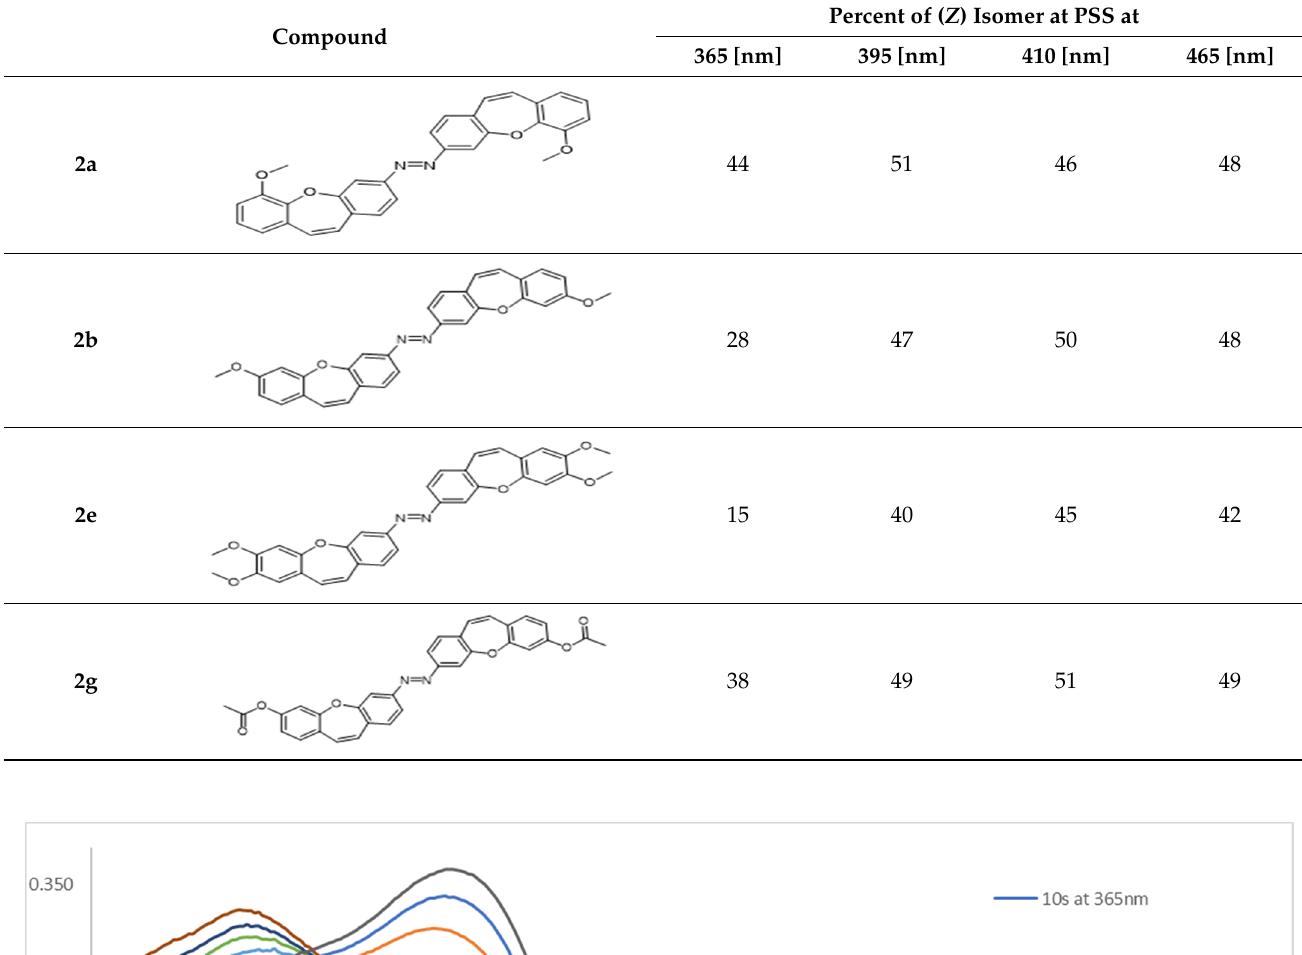
Figure 4. The hypsochromic shift in UV/VIS spectra of compound ( 2f ) upon irradiation with 365 nm. Table 5. Percentages of ( Z ) ( 2a , 2b , 2e , 2g ) isomers obtained from NMR spectra and at various PSSs (photostationary state) measured under constant illumination at the indicated wavelengths.